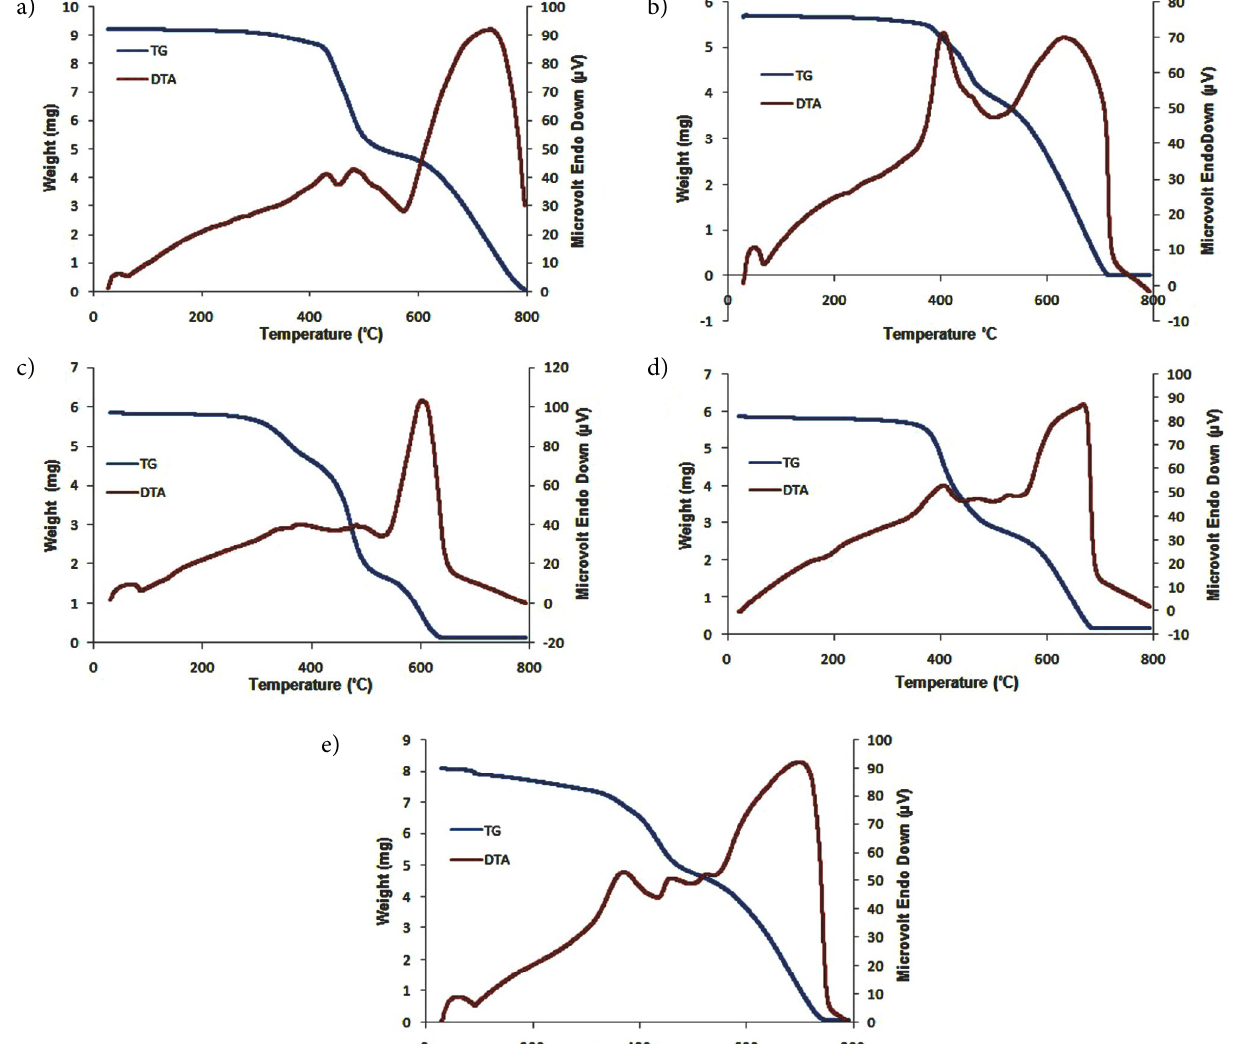
Figure 6 . TG/DTA graphs of polymers (a) P p HOBND (b) P p HOBPD (c) P p HOBCy (d) P o HOBPD and (e) P o HOBP conditions as